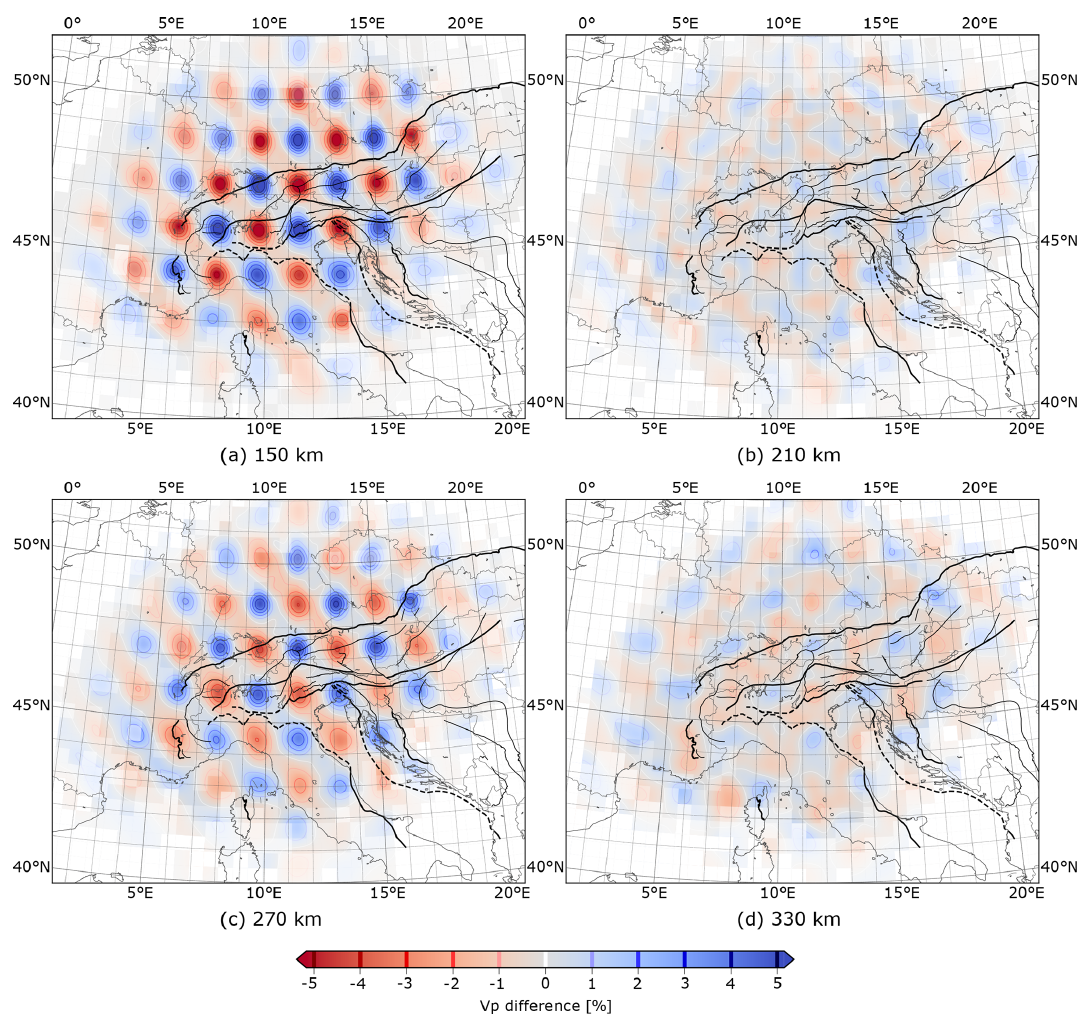
Figure 8. Results of checkerboard analysis after 12 iterations for the 3 × 3 × 4 grid. Misfit reduction is 87%. Horizontal slices in the left panel cut through the maxima of velocity anomalies. Slices in the right column cut through the unperturbed spaces in